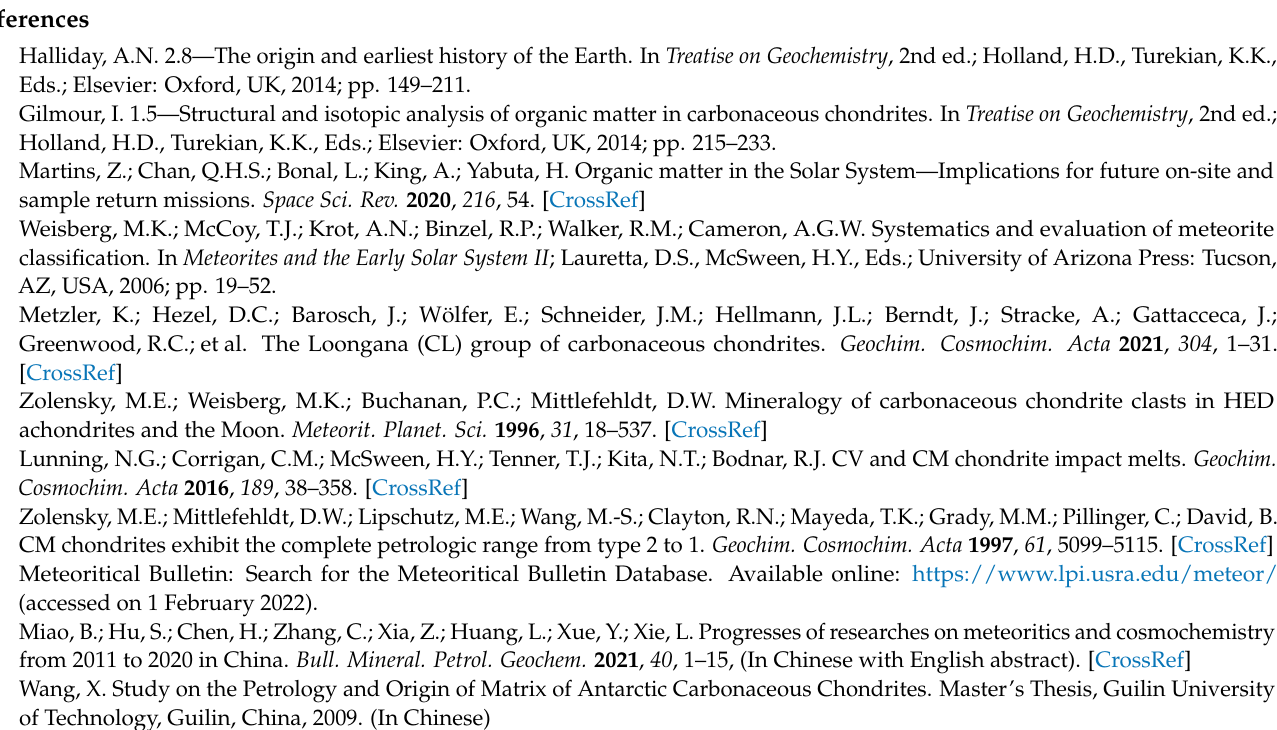
Table preparation and editing; M.Z. and J.G.: Figure preparation and editing; Z.Y. and W.H.: Review and editing. All authors have read and agreed to the published version of the